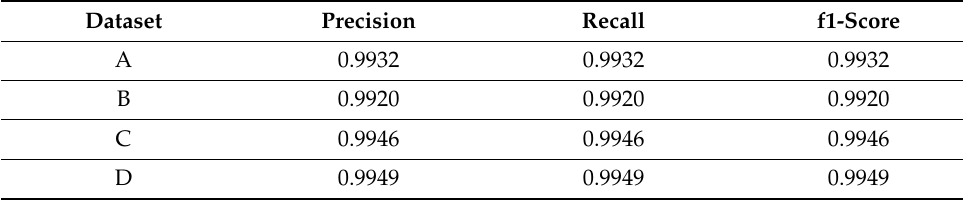
Table 4. Sensitivity analysis of the proposed model.